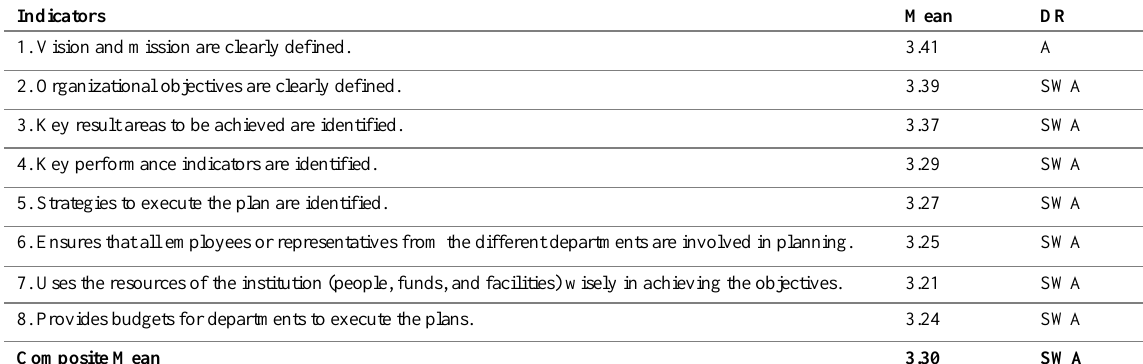
Table 2: The Leadership Skills of Administrators of Divine Word Colleges in the Ilocos Region in terms of Planning and Organizing